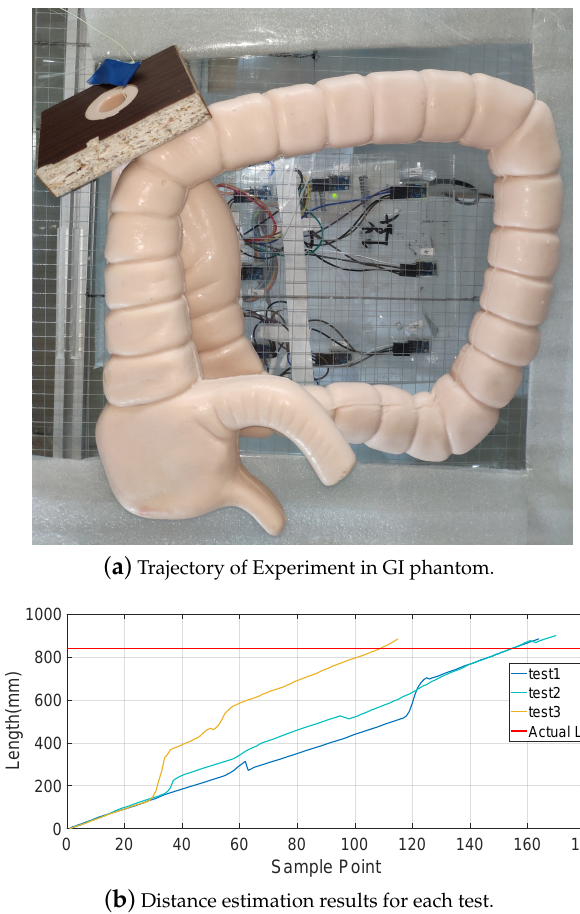
( b ) Distance estimation results for each test. Figure 14. Experiment in a GI phantom. In each test, the robot was placed at a depth of 840 mm from the exit, and then carried out by dragging with a rope. In this experiment, the length of the rope acted as ground truth, which was then compared with the accuracy of the magnetic positioning system to judge the reliability of our system.